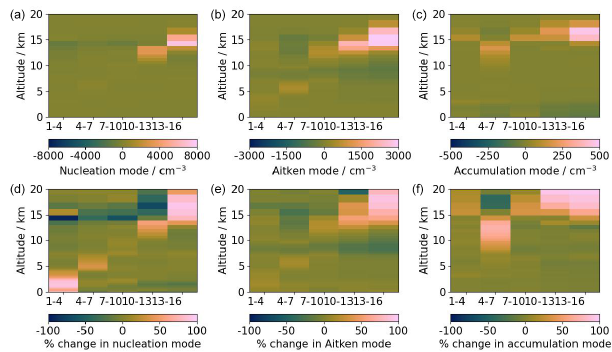
Figure 10. The absolute (a–c) and percentage (d–f) changes of the regional domain-averaged profiles of ambient number concentra- tions of ( a and d ) nucleation mode aerosol, ( b and e ) Aitken mode aerosol, and ( c and f ) accumulation mode aerosol, between the sim- ulations with NPF switched on at certain altitudes (NPF_1-4km, NPF_4-7km, NPF_7-10km, NPF_10-13km, and NPF_13-16km in- dicated as altitude ranges in the x -axis labels) and the simulation with no NPF in the regional domain